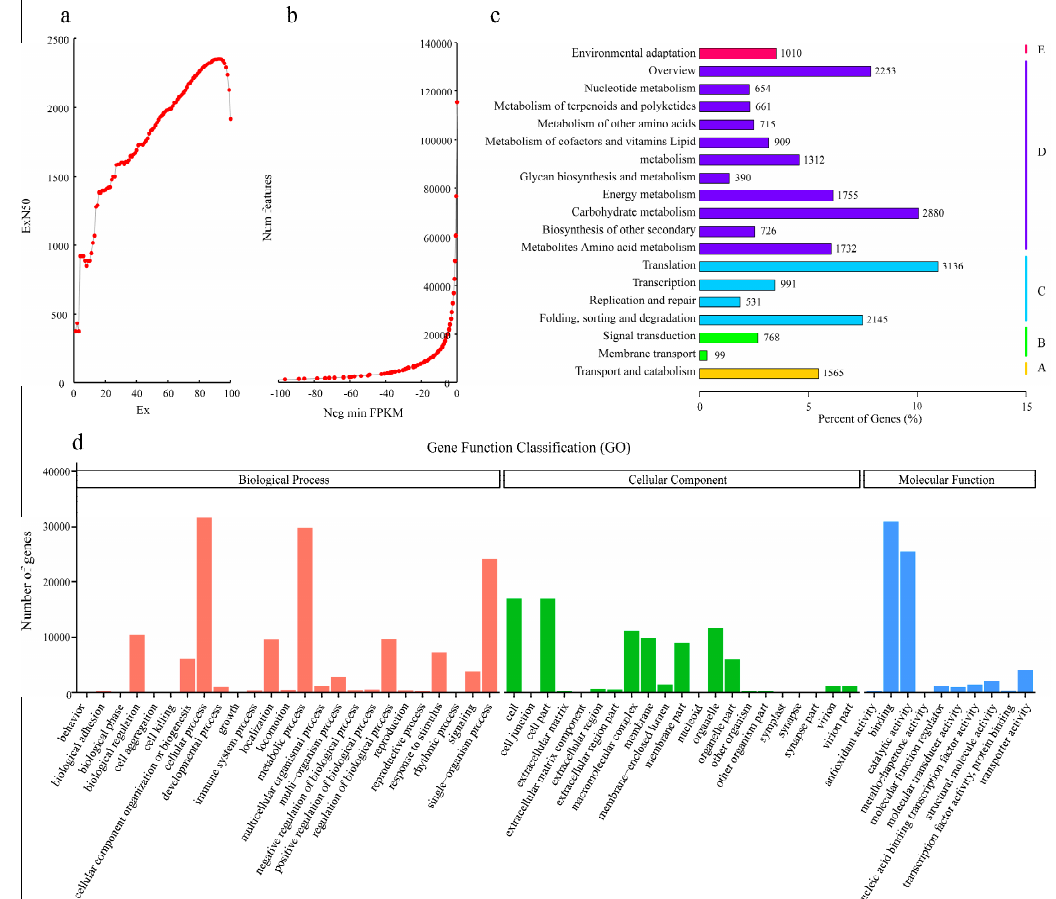
Figure 2. Assembly quality assessment. ( a ) N50 of subset of transcript by decreasing the expression level. Ex denotes the top-most expressed transcripts that represent x% of the data. ExN50 is the length of a transcript, while the total length of transcripts shorter than it reached 50% of the total length of all transcripts in this dataset. ( b ) Transcript count with a threshold of negative minimum FPKM (fragments per kilobase of the exon model per million mapped reads) value. ( c ) The classification of the Kyoto Encyclopedia of Genes and Genomes (KEGG) pathways. ( d ) The classification of the Gene Ontology (GO)